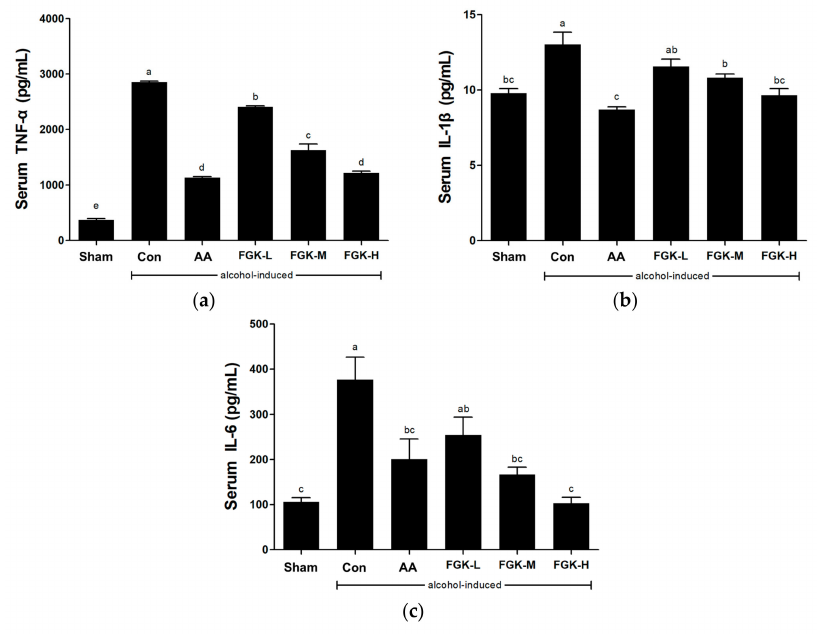
Figure 6. Effects of fermented gold kiwi (FGK) on serum cytokines levels in alcohol-induced mice. ( a ) TNF- α , ( b ) IL-1 β , and ( c ) IL-6. Sham, mice treated with only saline; Con, mice treated with alcohol and saline; AA, mice treated with alcohol and ascorbic acid (25 mg/kg); FGK-L, -M, -H, mice treated with alcohol and FGK at 50, 126, and 250 mg/kg, respectively. Results expression as means ± SEM ( n = 8). a–e Different letters indicate significant differences ( p < 0.05) among the groups, as determined by Tukey’s